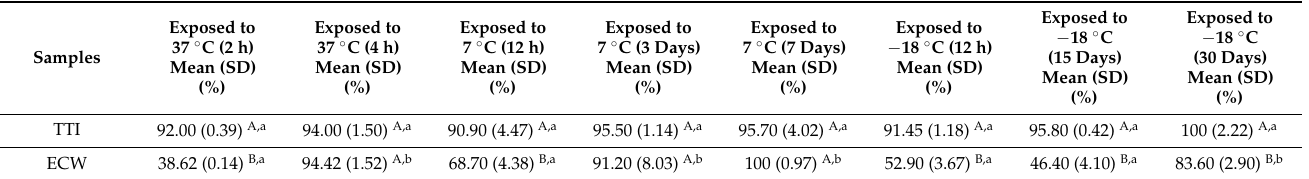
Table 2. Comparison of the percentage of antitrypsin activity between ECW and TTI exposed to different temperature and time